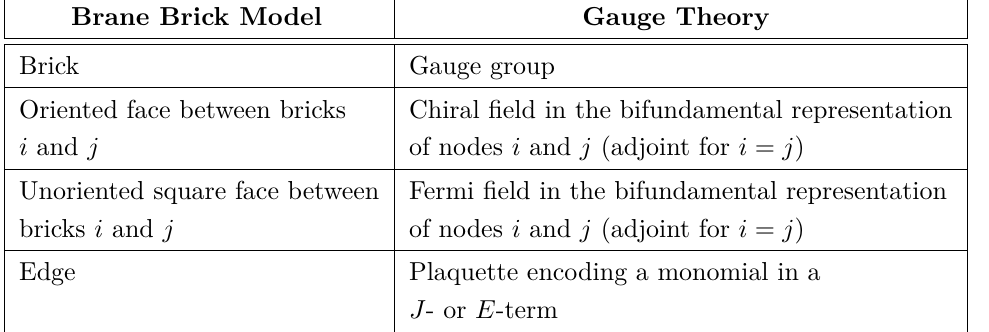
Table 4 . Dictionary between brane brick models and 2 d gauge